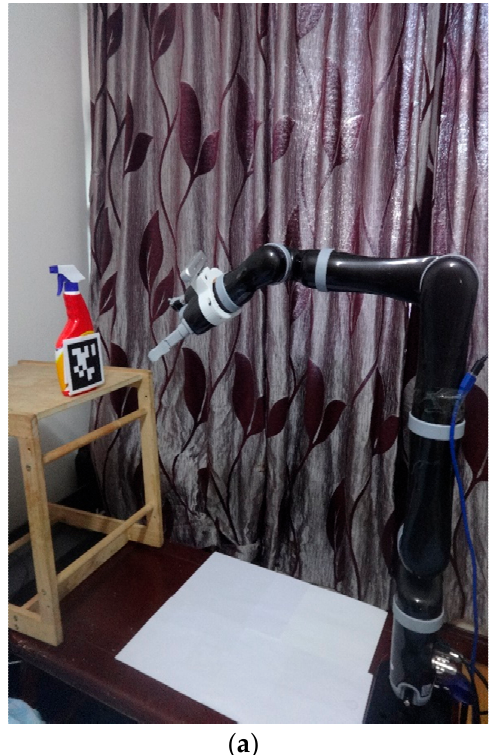
Table 3. Effects of adaptive gain on the convergence rates of IBVS controller.